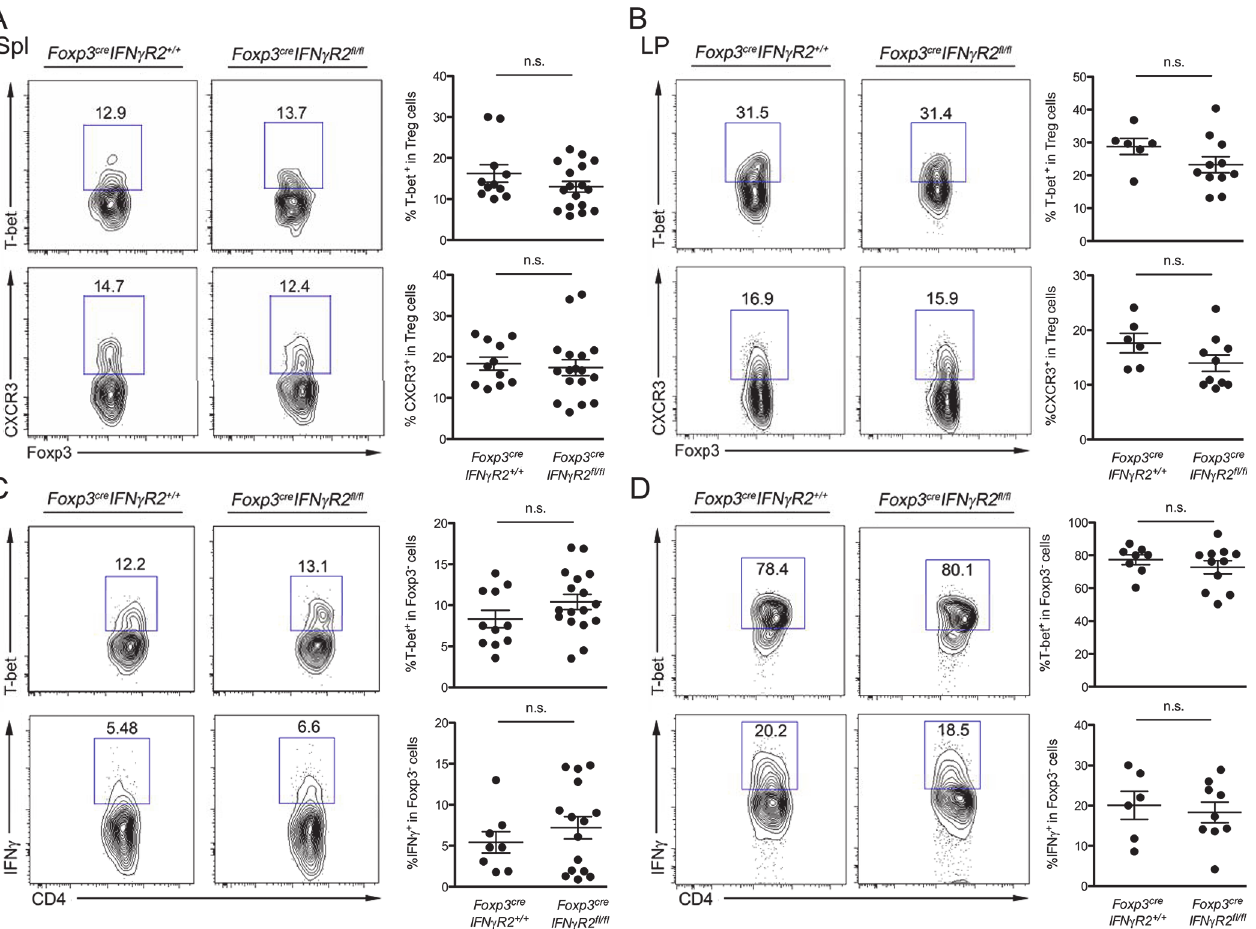
Fig 1. Minimal role of Treg cell-intrinsic IFN γ signaling in promoting T-bet + CXCR3 + Treg cells. FACS analysis and frequencies of T-bet + or CXCR3 + cells in Foxp3 + CD4 + Treg cells in (A) the spleen (Spl) and (B) the lamina propria (LP) of small intestine. FACS analysis and frequencies of T-bet + or IFN γ + Foxp3 - CD4 + Teff cells in (C) Spl and (D) LP isolated from Foxp3 cre IFN γ R2 fl/fl or Foxp3 cre IFN γ R2 +/+ mice. FACS plots shown are representative of three independent